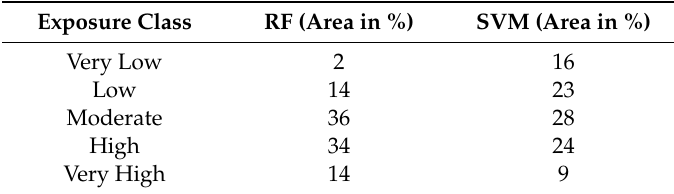
Figure 6. Landslide exposure maps derived using random forest (RF) and support vector machine (SVM) for the State of Salzburg. Table 3. Area percentage for each exposure class for landslides using RF and SVM for the State of